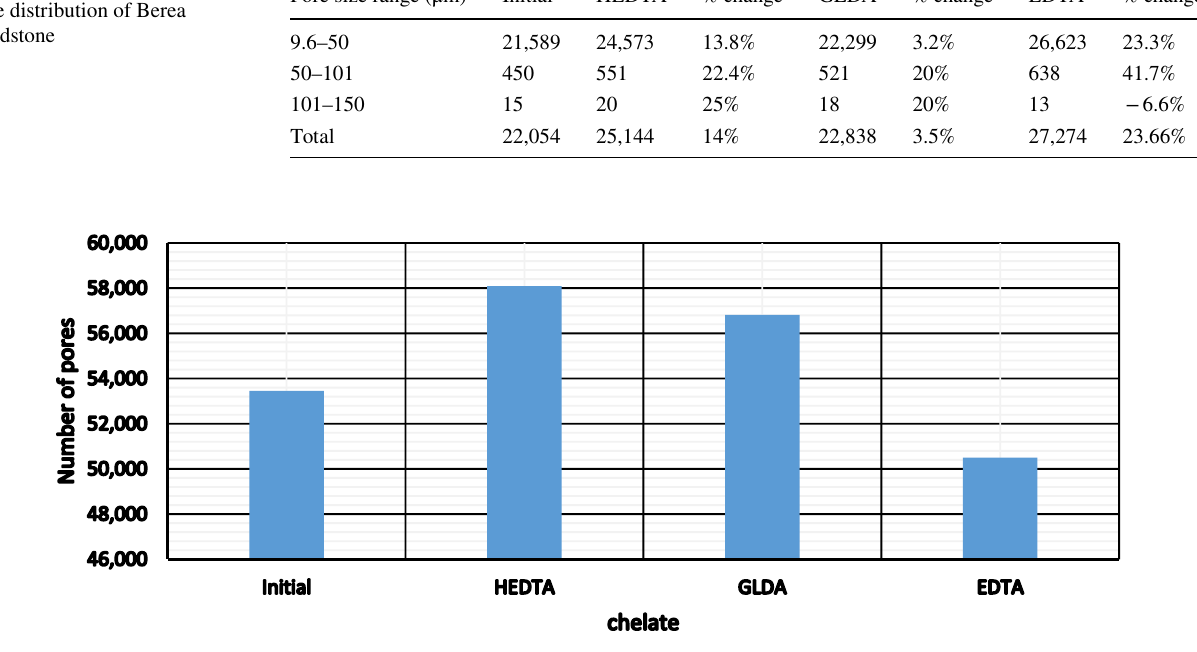
Table 5 Initial and final pore